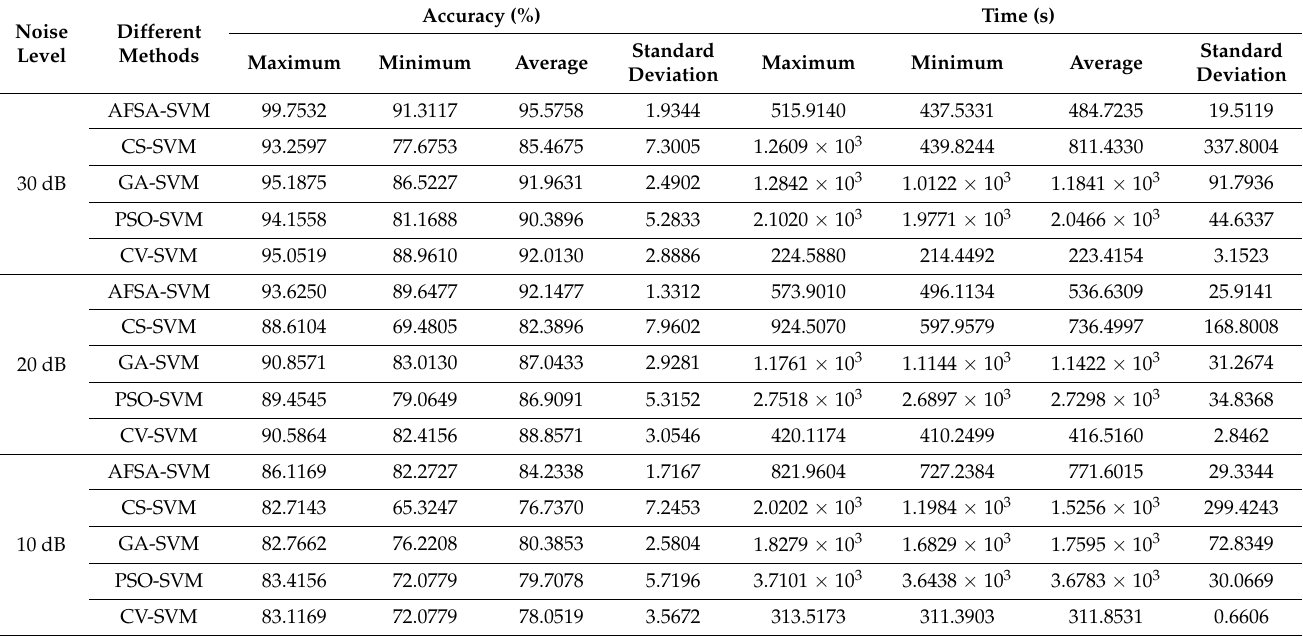
Table 6. Comparison of diagnosis results with different classification